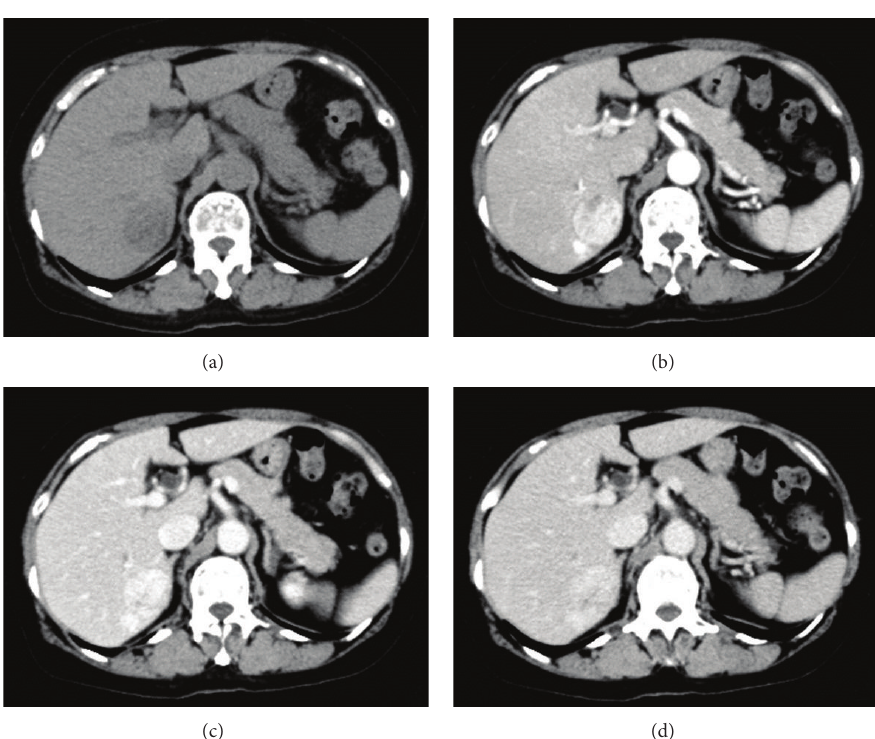
Figure 1: Dynamic contrast enhancement computed tomography (CT). Plain CT revealed a low-density tumor in segment 6 (a). Tumor hypervascularity in the arterial phase (b). Hypervascular lesions remained in the portal phase (c) and late phase